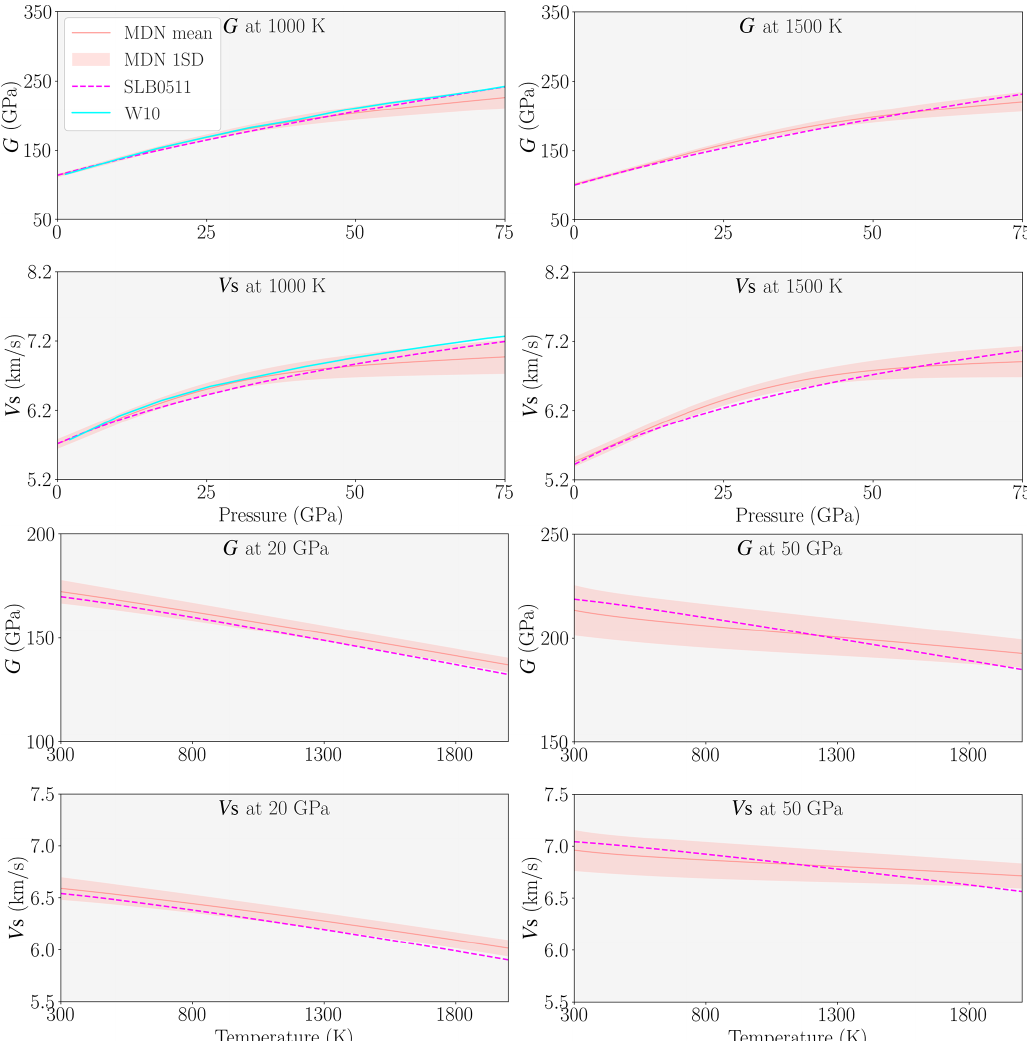
Figure E1. P – T – V s relationship of MgO predicted by neural networks along 1000 and 1500K isotherms and 20 and 50GPa isobars. Previously published studies (Stixrude and Lithgow-Bertelloni, 2005, 2011; Wentzcovitch et al., 2010b) are also shown for comparison.